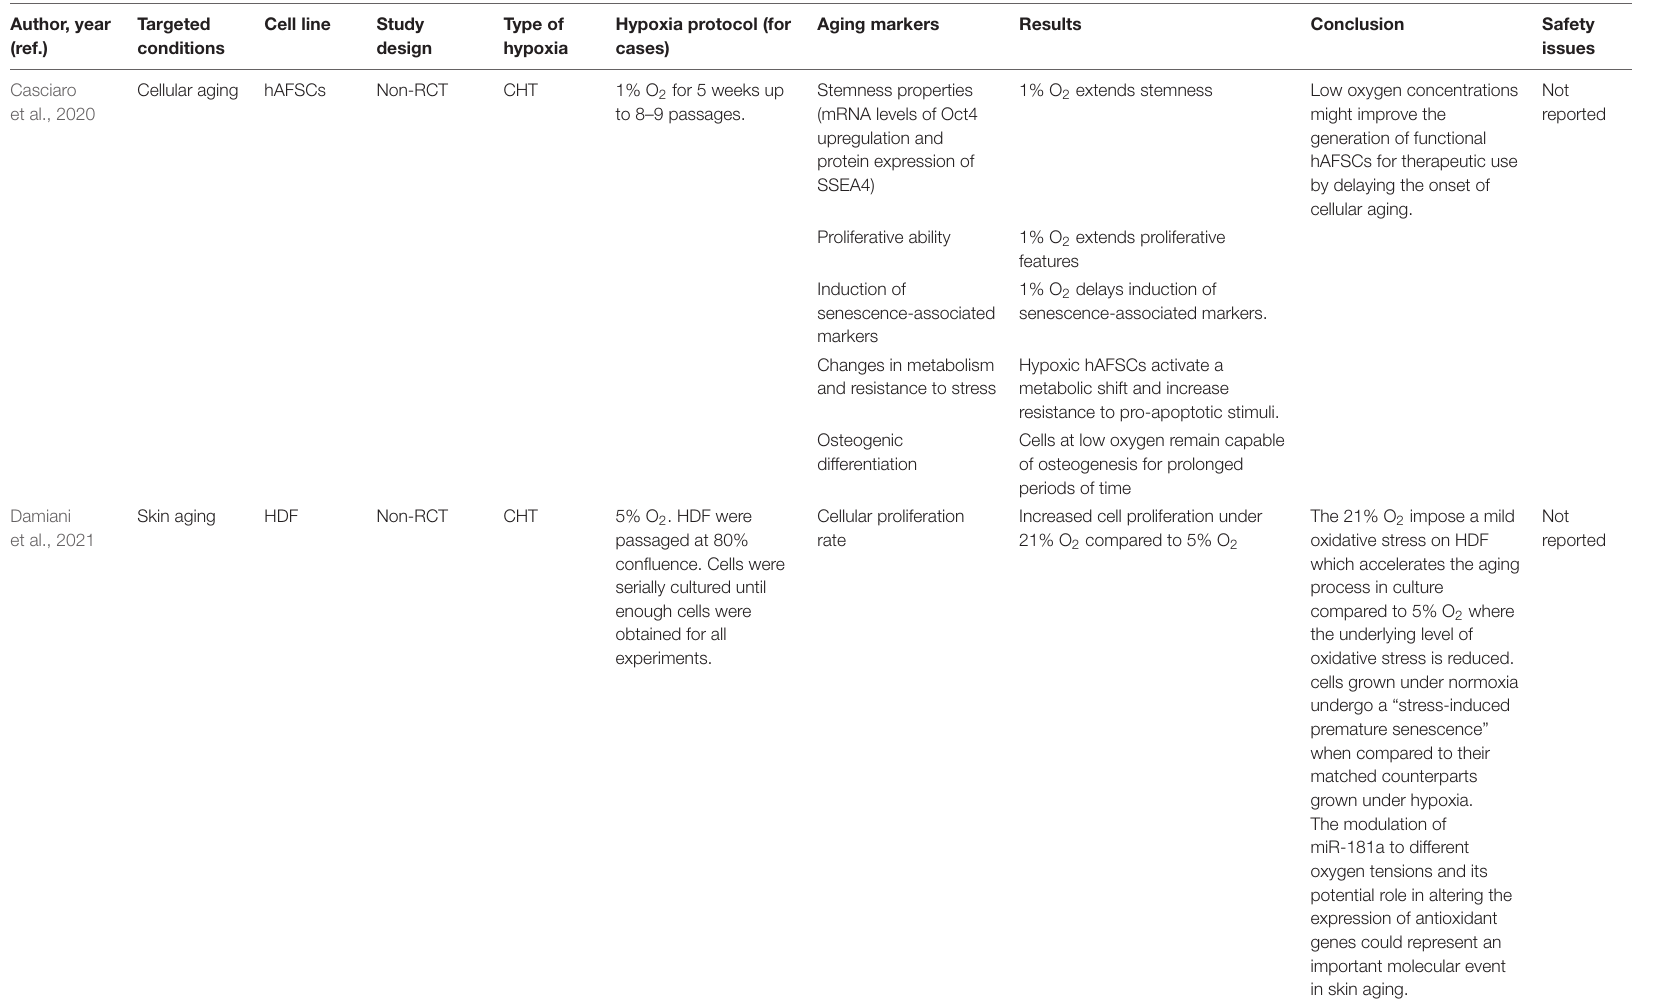
TABLE 3 | The effects of IHNT and CHT on aging markers and age-related diseases using cell culture. Author, year